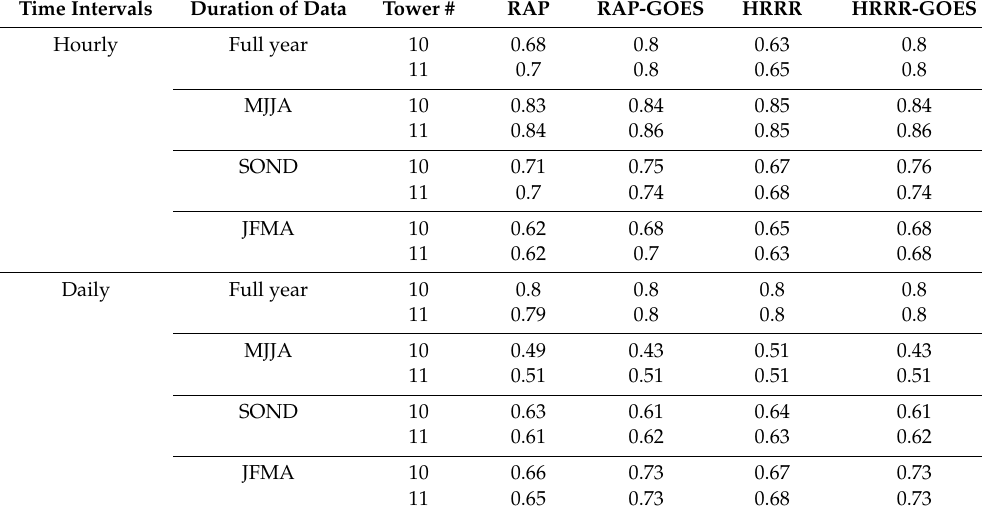
Table 3. Spearman correlation coe ffi cients ( ρ ) of the modeled AET against observed AET using hourly and daily data with respect to yearly and seasonal (four-month intervals) duration.